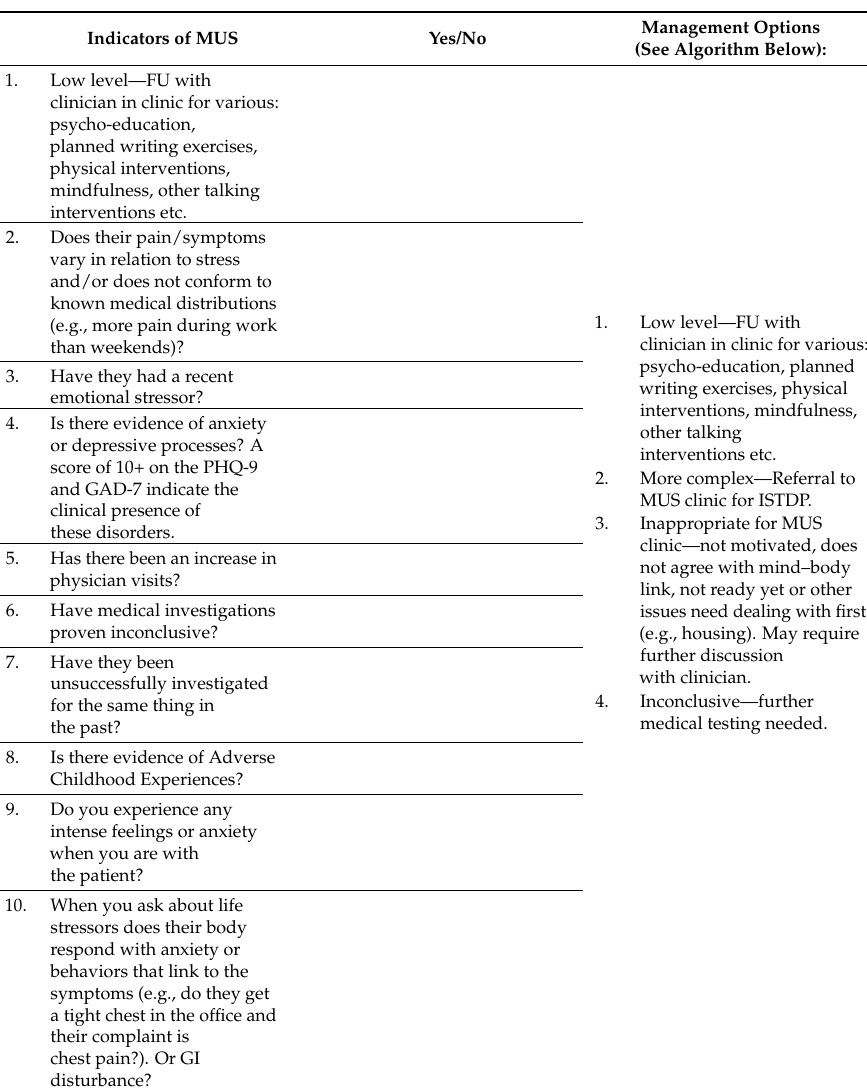
Table A1. 10-point Checklist to help rule in MUS